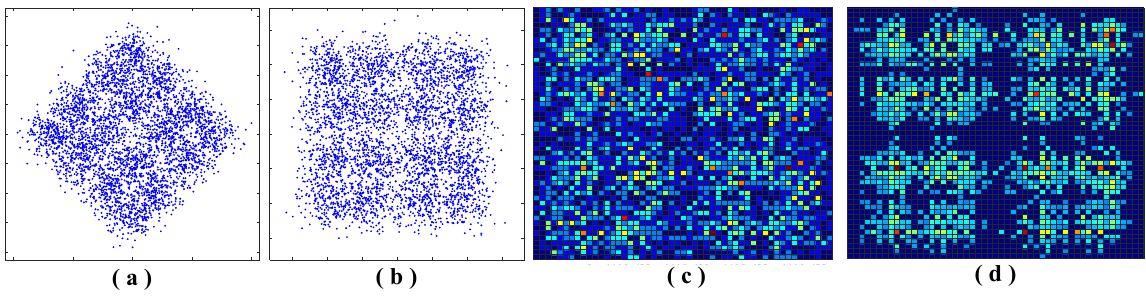
Figure 6. The average power of signals after the square operation.